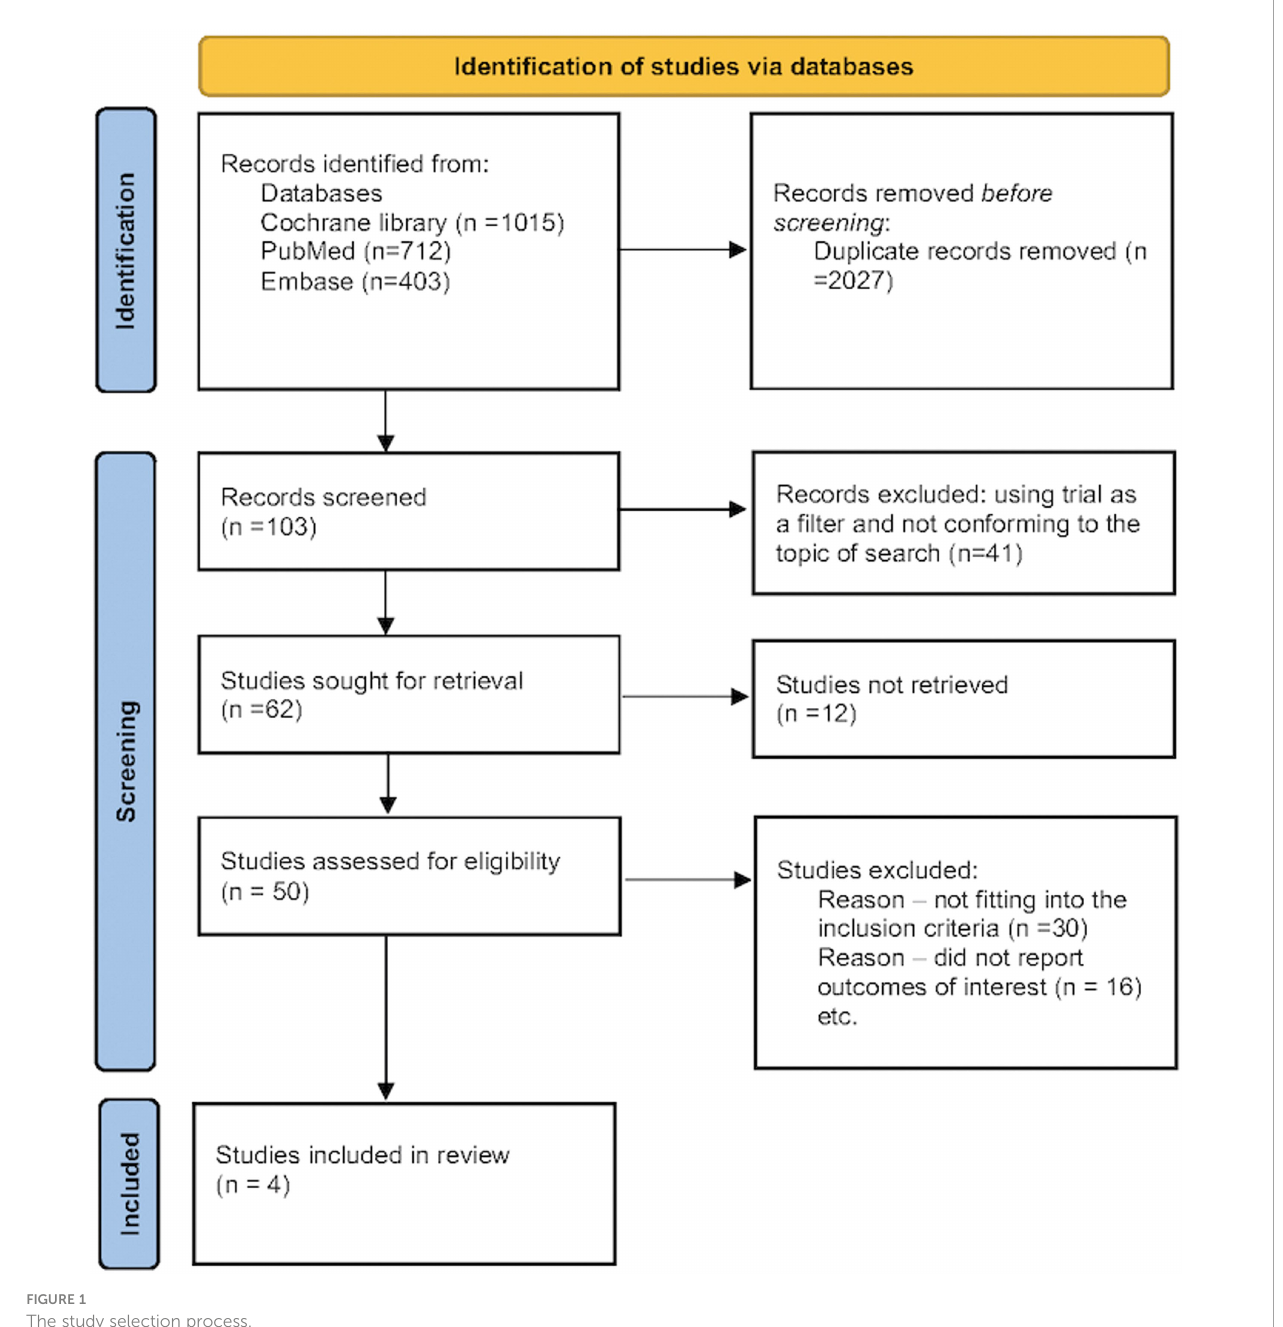
FIGURE 1 The study selection